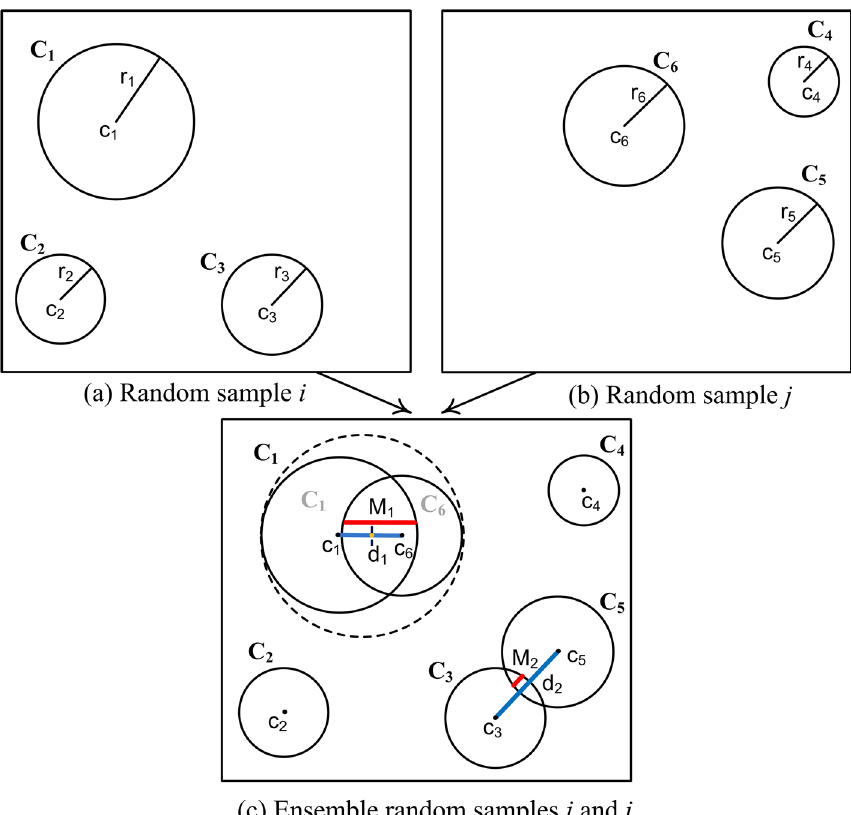
Fig. 1 Illustration of separate and overlapping cluster balls. a and b show the cluster balls of two RSP blocks, three cluster balls each; c the disjoint and intersection cluster balls from the two RSP